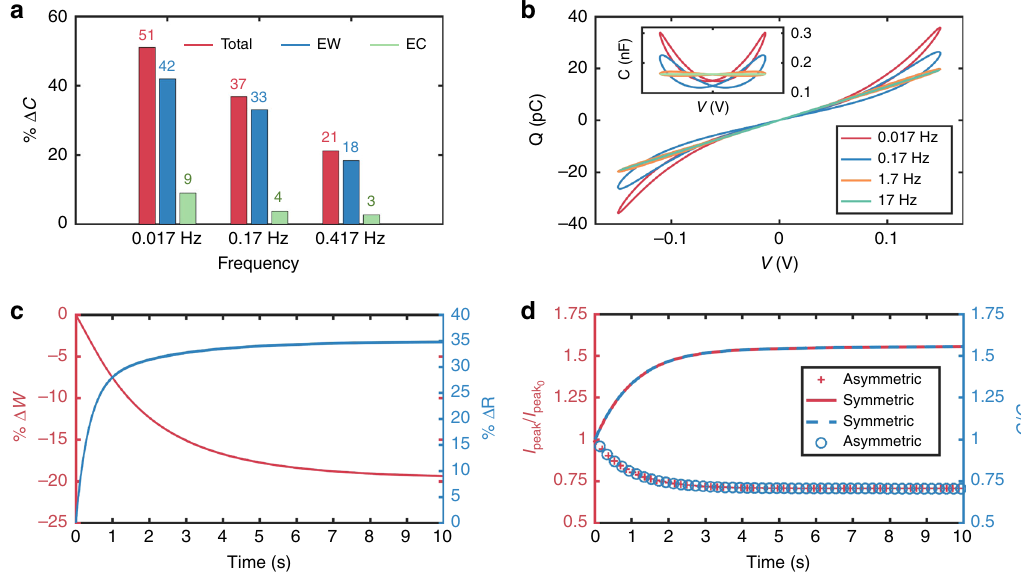
Fig. 8 Simulated memcapacitance in symmetric and asymmetric membranes in decane. a Percentage contributions of EW and EC mechanisms to the steady-state change in capacitance versus excitation frequency. Percentages were computed from the outputs of simulating the geometrical and total capacitive responses of a DPhPC bilayer in decane (Fig. 6). b Simulated Q - v loops using the state equations and fi tted parameters provided in Table